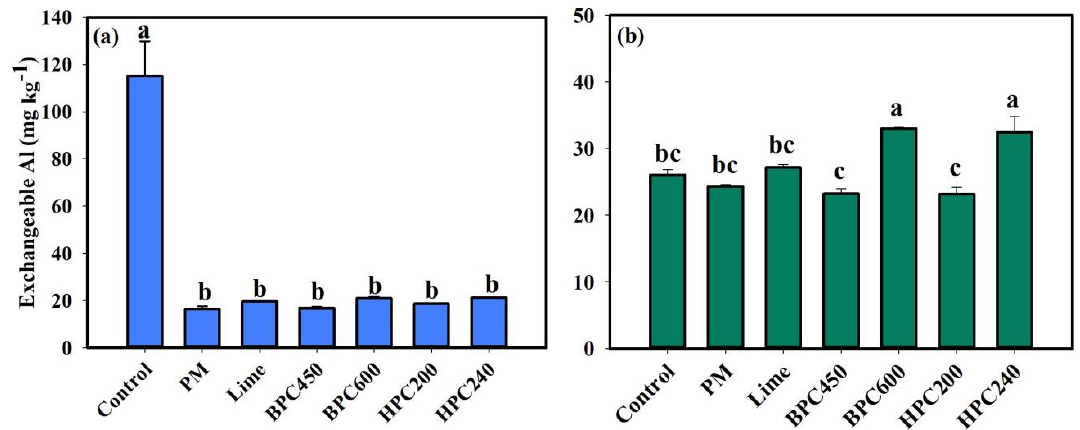
Figure 1. Exchangeable Al extracted by NH 4 Cl ( a ) and CaCl 2 ( b ). Means followed by the same letter are not significantly different ( p < 0.05) using Tukey’s HSD test.